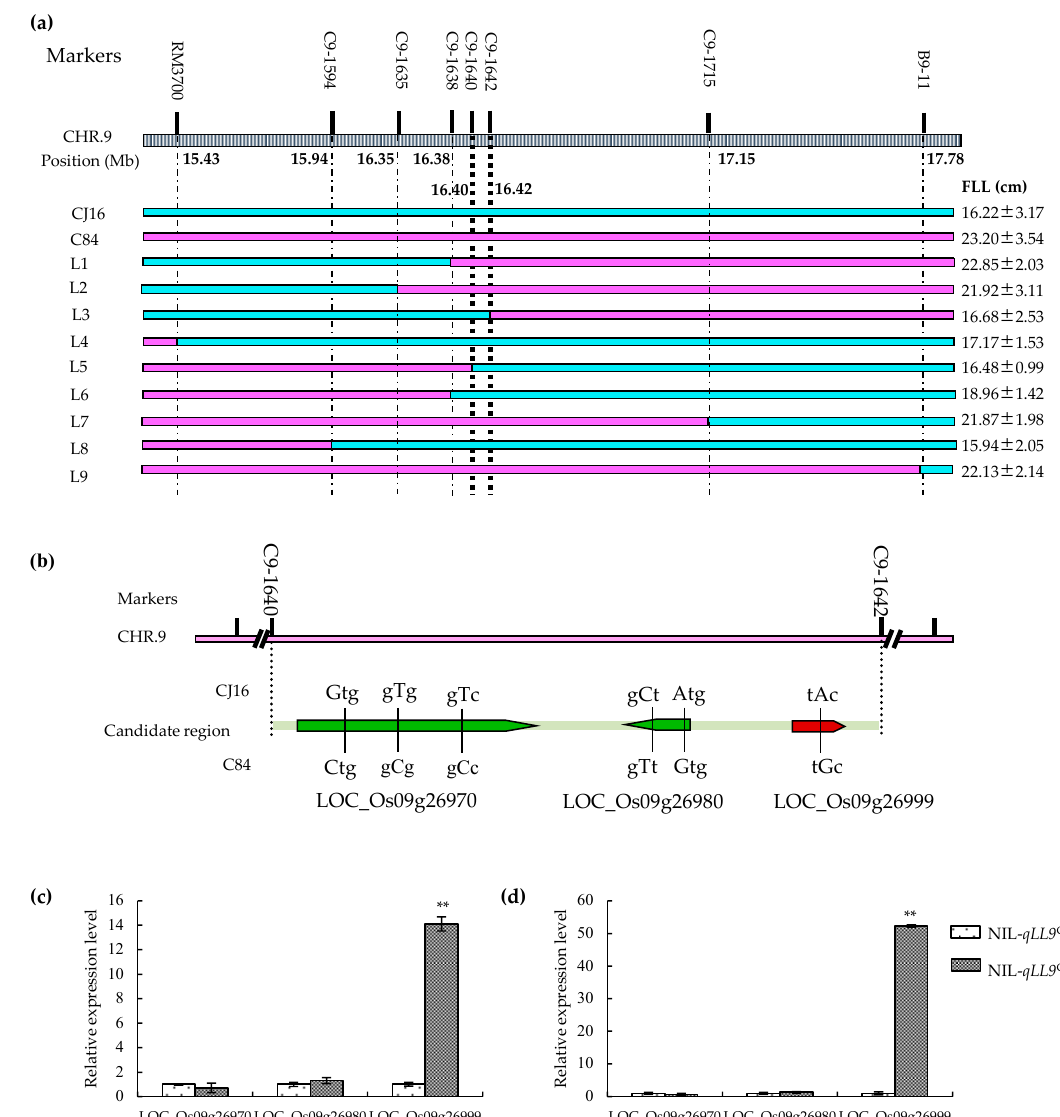
Figure 4. Map-based cloning of qLL9 and expression analysis of candidate genes. ( a ) High-resolution mapping of qLL9 . Numbers on the map indicate the physical distance on chromosome 9. Nine recombinant plants were used to refine the candidate region to 16.17 kb region by substitution mapping, in which green and pink rectangles indicate the homozygous CJ16 genotype and homozygous C84 genotype, respectively. Flag leaf length (FLL) values were obtained from the corresponding selfed progenies and represented as mean ± SD ( n = 12). ( b ) Predicted open reading frames and sequence difference of the qLL9 between CJ16 and C84 are shown. Relative expression of three candidate genes LOC_09g26970 , LOC_09g26980 , and LOC_09g26999 of near isogenic line (NIL)- qLL9 CJ16 and NIL- qLL9 C84 at tillering stage ( c ) and heading stage ( d ) by quantitative real-time polymerase chain reaction (qRT-PCR). Data are mean ± SD ( n = 3). Asterisks represent significant difference determined by Student’s t -test at p -value < 0.01 (**).